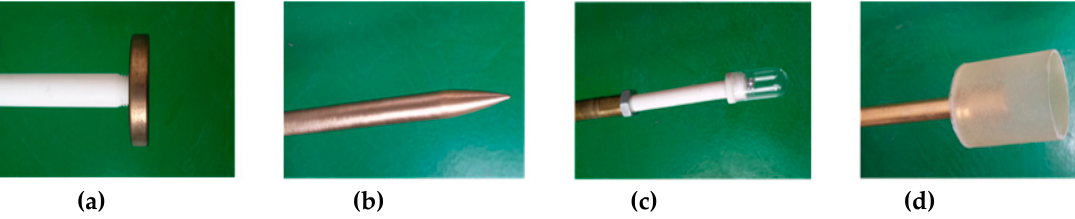
Figure 11. Simulative Gas Insulated Switchgear (GIS) chamber and its related accessories.